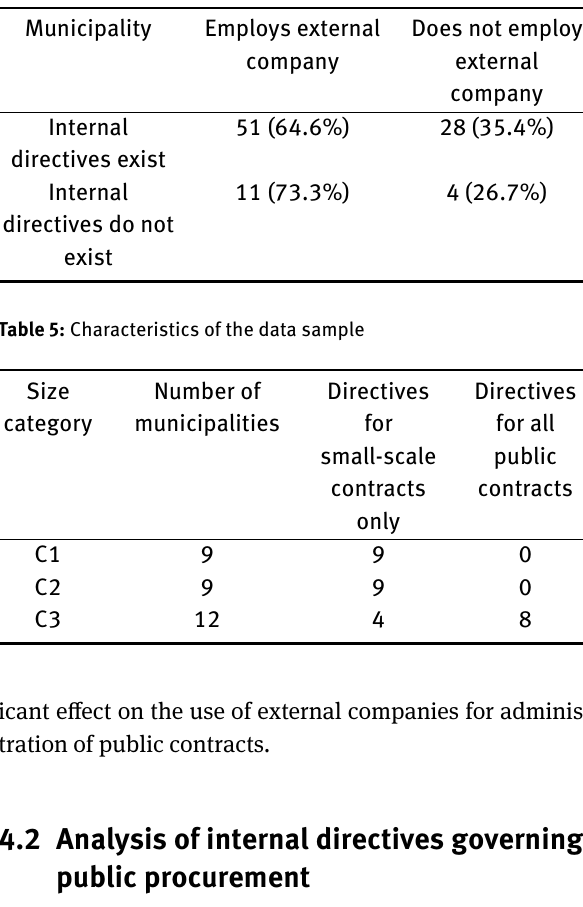
Table 4: Numbers concerning the existence of internal directives and the possibility to use external companies.